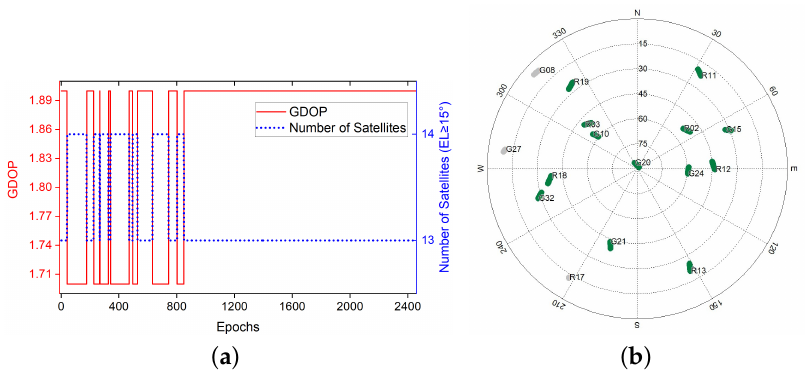
Figure 3. Geometric Dilution Precision (GDOP) and Sky Map during data sampling of experiment Section 3.1 ( a ) GDOP values and number of satellites. ( b ) Sky map of visible satellites, with a gray track indicating that the satellite’s altitude is less than 15 ◦ [29].